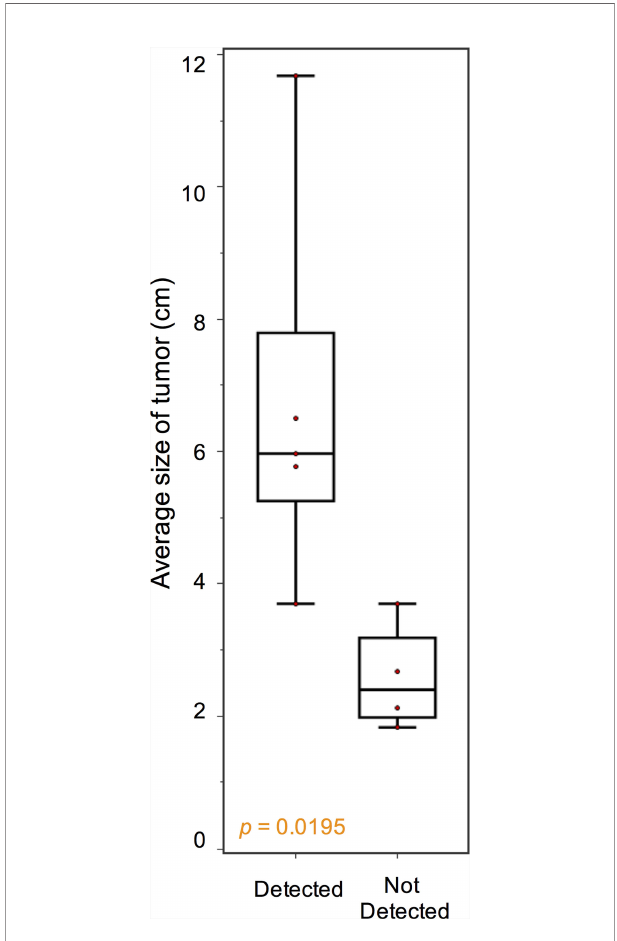
FIGURE 2 | Association between KIT ctDNA mutation detection and tumor burden. In patients with advanced progressive GIST, tumor burden, as measured by the average diameter of the 3 largest lesions, was higher with detectable KIT ctDNA mutation than in those without (median, 5.97 cm vs. 2.40 cm, p =